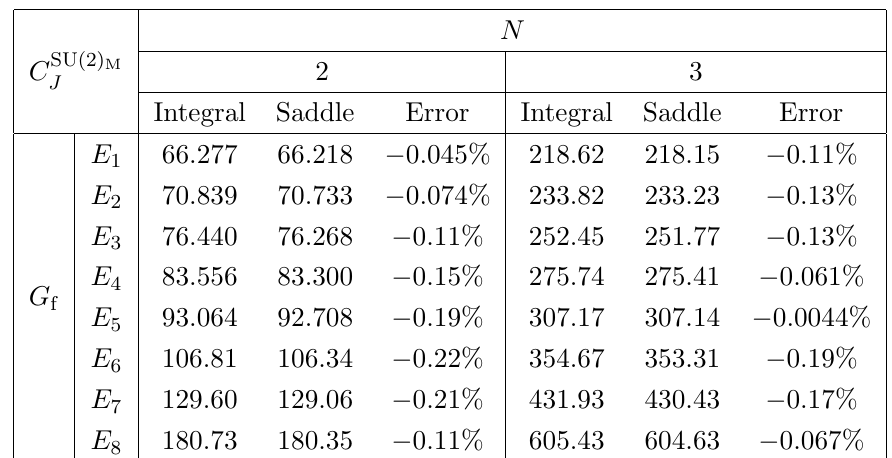
Table 4 . The perturbative values of the mesonic (cid:13)avor central charge C SU(2) M to rank-three Seiberg theories, computed by numerical integration and by the saddle point